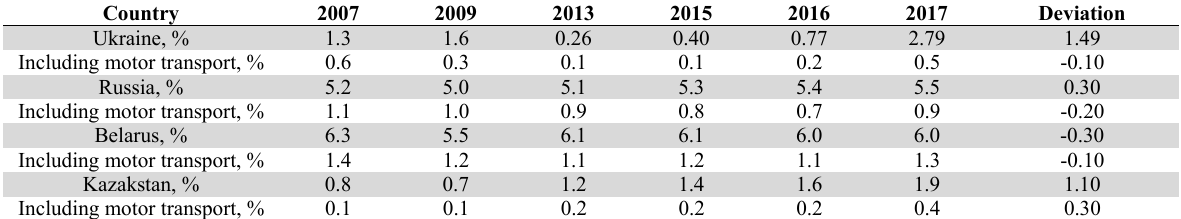
Dynamics of the state’s share in financing the development, purchase and implementation of innovations by enterprises in key countries of the post-Soviet economic space in 2007–2017 (including motor transport enterprises)